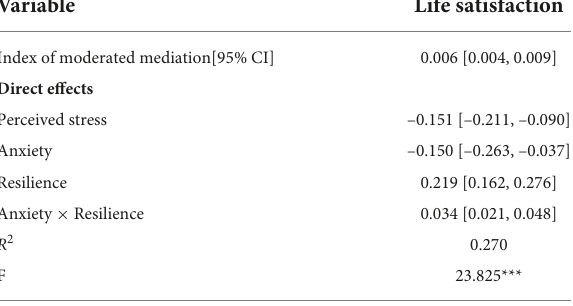
TABLE 4 The moderated mediation model with anxiety as a mediator and resilience as a moderator ( n = 654). Variable